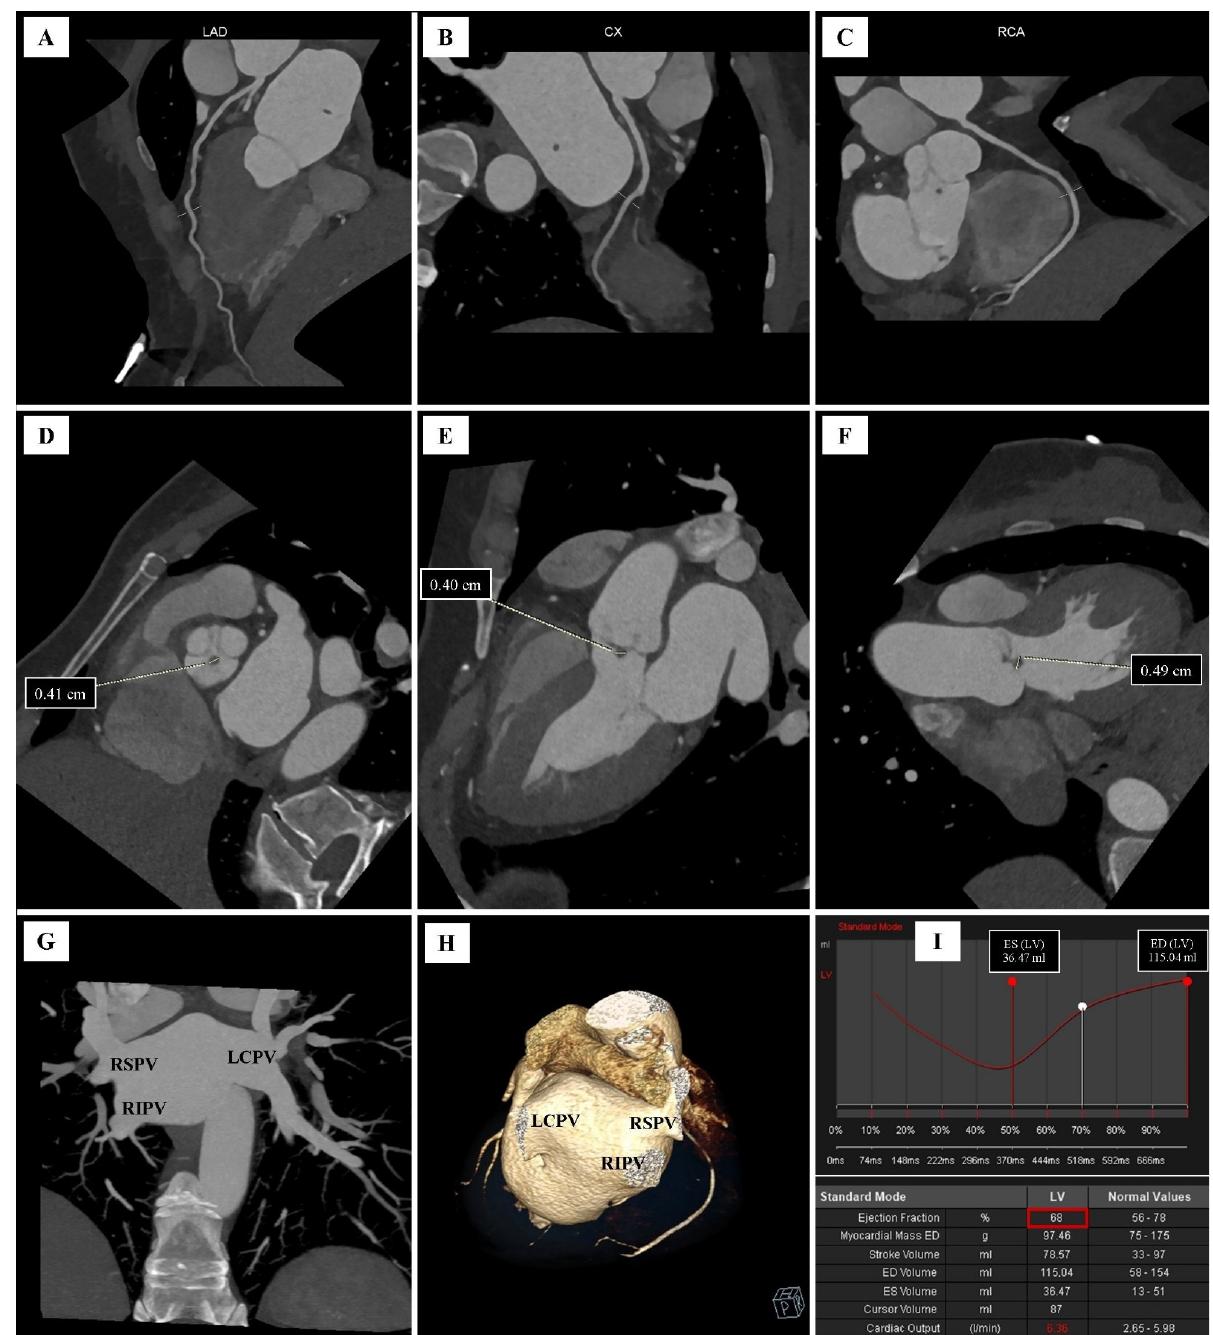
Figure 2. Cardiac computer tomography angiography (CCTA): ( A ) curved planar reconstruction (CPR), left anterior descending artery (LAD); ( B ) CPR reconstruction, left circumflex artery (LCx); ( C ) CPR reconstruction, right coronary artery (RCA); ( D ) multiplanar reconstruction (MPR); oblique view, parallel to the aortic annulus; dimensioning the maximum diameter of a fibroelastoma; ( E ) MPR reconstruction, long axis, three − chamber projection, dimensioning the maximum diameter of a fibroelastoma; ( F ) MPR reconstruction; long axis, parallel to the two − chamber projection; dimensioning the maximum diameter of a fibroelastoma; ( G ) maximum intensity projection (MIP) reconstruction; oblique view; right superior pulmonary vein (RSPV), right inferior pulmonary vein (RIPV) and left common pulmonary vein (LCPV) leading to the left atrium; ( H ) volume rendering tech- nique (VRT) reconstruction; RSPV, RIPV and LCPV leading to the left atrium; ( I ) left ventricular functional